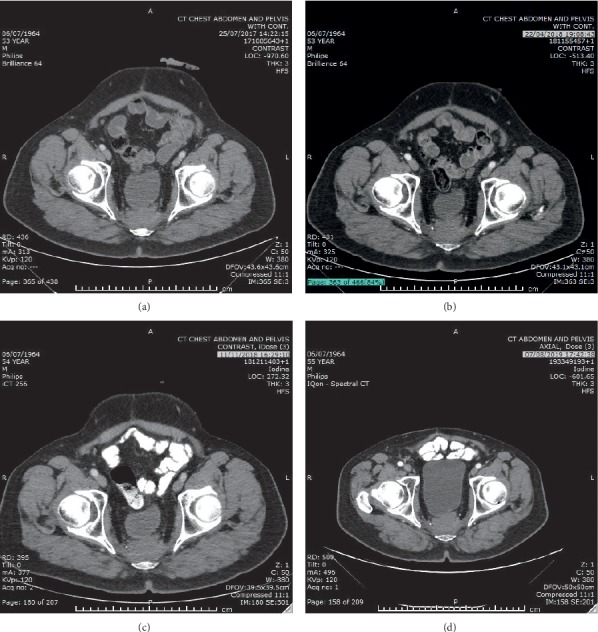
Stability of presacral CRC metastatic lesion on PARP inhibitor therapy. Axial computed tomography scans during treatment are provided: (a) July 2017, (b) April 2018, (c) November 2018, and (d) August 2019.